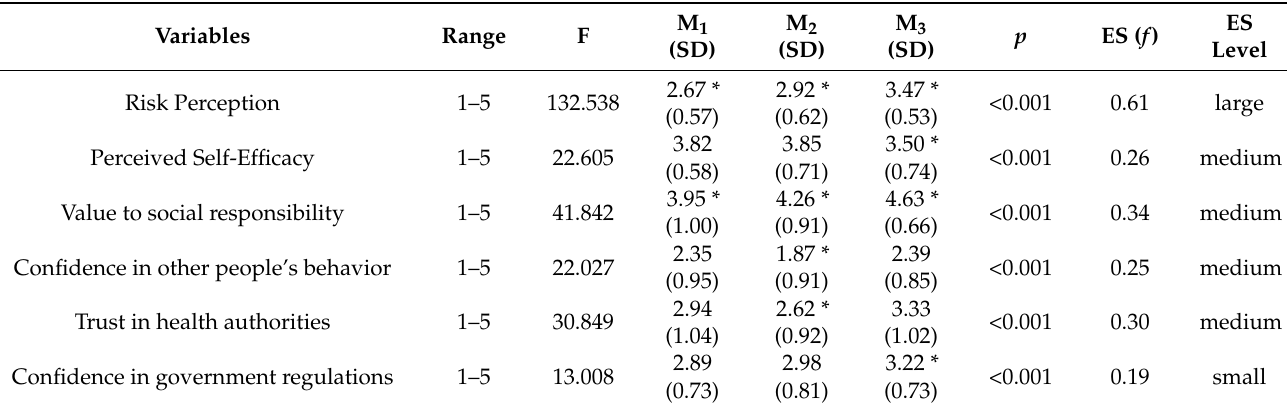
Table 8. Variations in average scores in the three intervals.